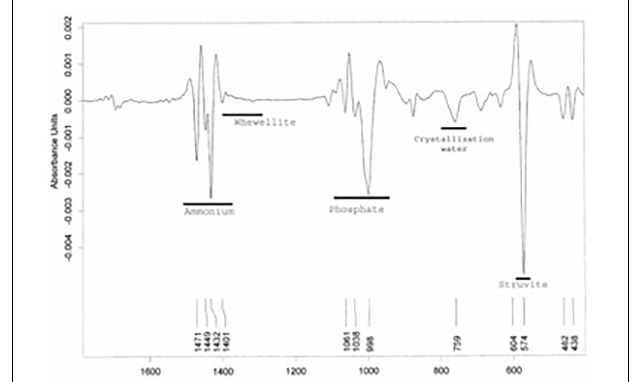
FIGURE 4 | Exemplified spectrum analysis by Fourrier Transformed Infra-Red (FTIR) spectroscopy with main component identified.